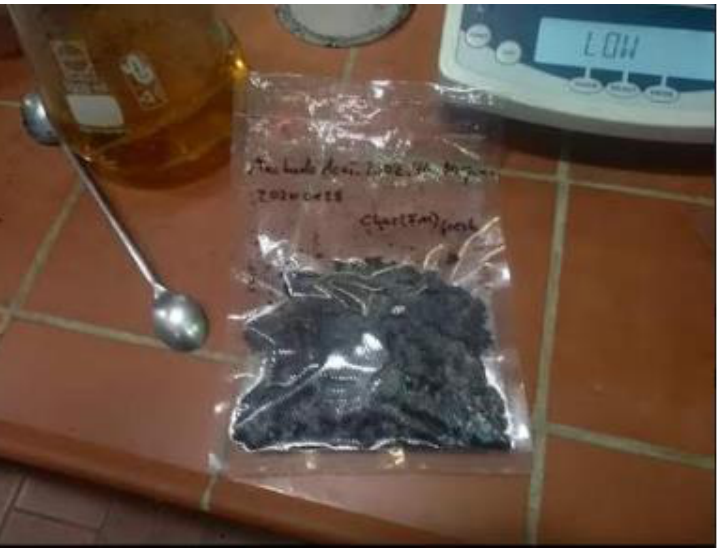
Figure 3. Solid phase (bio-char) and aqueous phase (orange) reaction products. The investigated process parameters (reaction time, biomass-to-H 2 O ratio, tempera- ture, mass of corn stover and mass of H 2 O) are described in Table 1. Table 1. Process parameters by hydrothermal carbonization of corn stover at 250 °C with a bio- mass/H 2 O ratio of 1:10 after 60, 120 and 240 min and at 250 °C, 240 min, biomass/H 2 O ratios of 1:10,